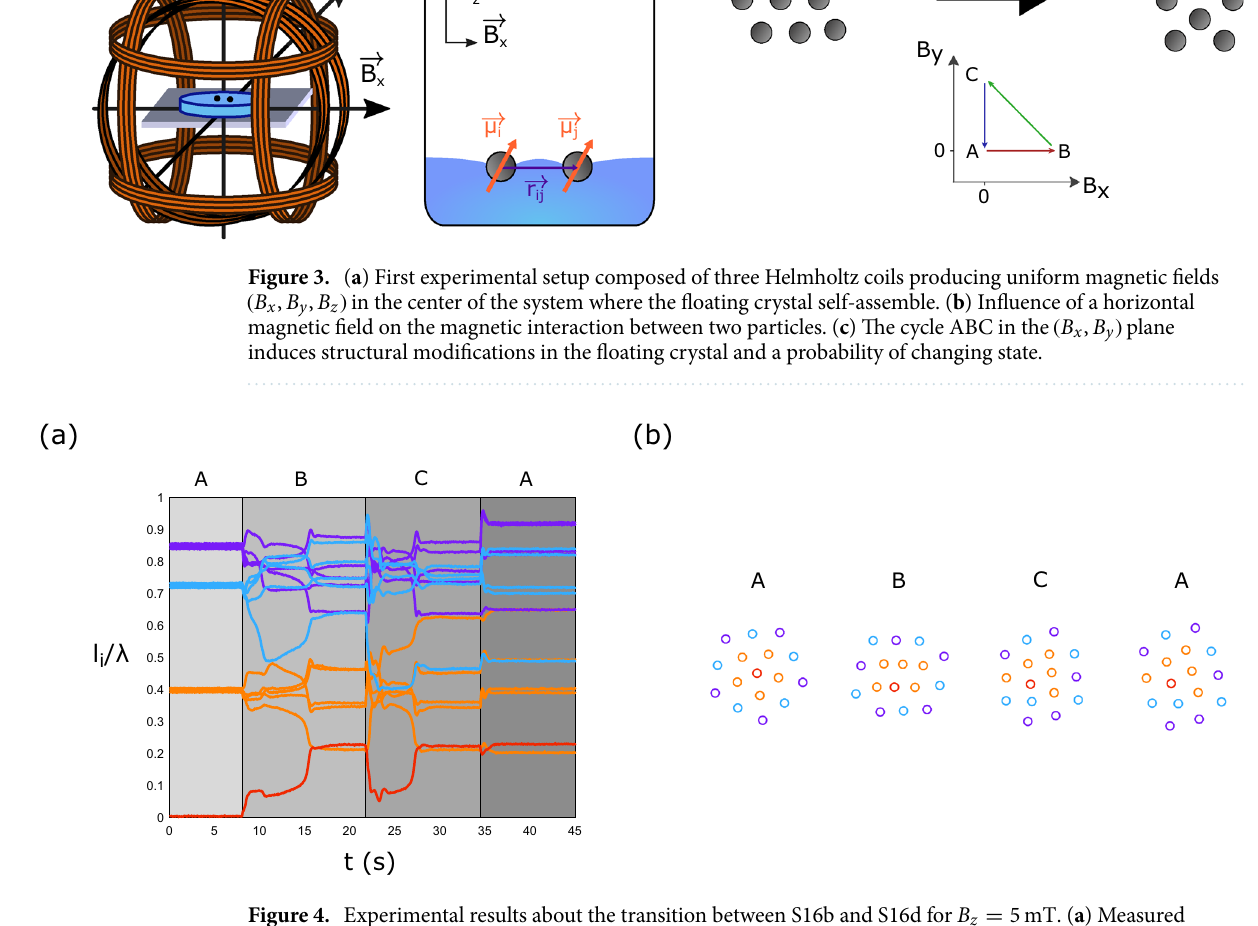
the capillary length (cid:31) . Every metastable state is characterized by a defined set function of time is given in Fig. 4a for the transition between S16b and S16d. Four steps were observed in the transition corresponding to stages A, B or C of the cycle in the ( B x , B y ) space (see Fig. 3c). In Fig. 4b are drawn the stable states of the assembly corresponding to the stages A, B, C and A. The beads and their normalized distance ( l i / (cid:31) ) are colored according to their distance from the center of mass in the initial state S16b. Given the symmetry